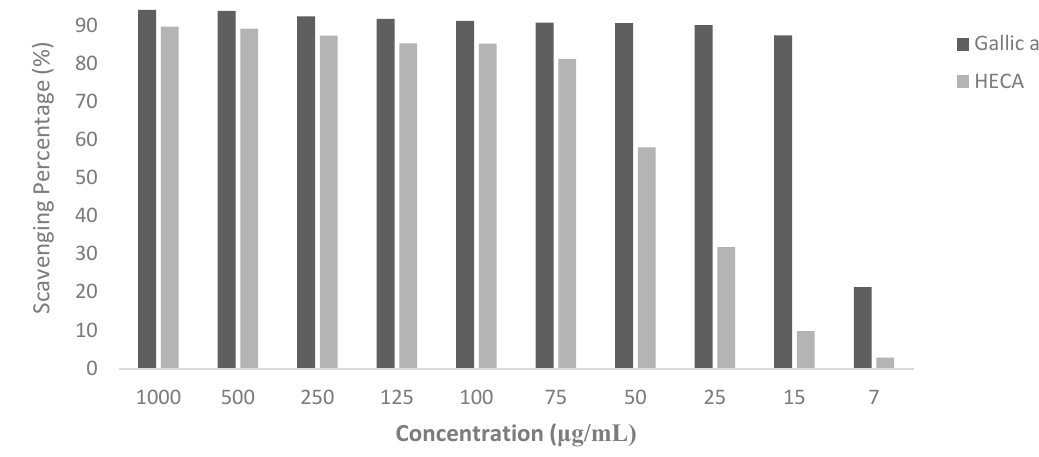
Figure 2. DPPH radical scavenging potential of gallic acid as the reference compound and hydroalcoholic extract of Curatella americana (HECA). The mean of scavenging percentage was significative different in all concentrations at p < 0.01.